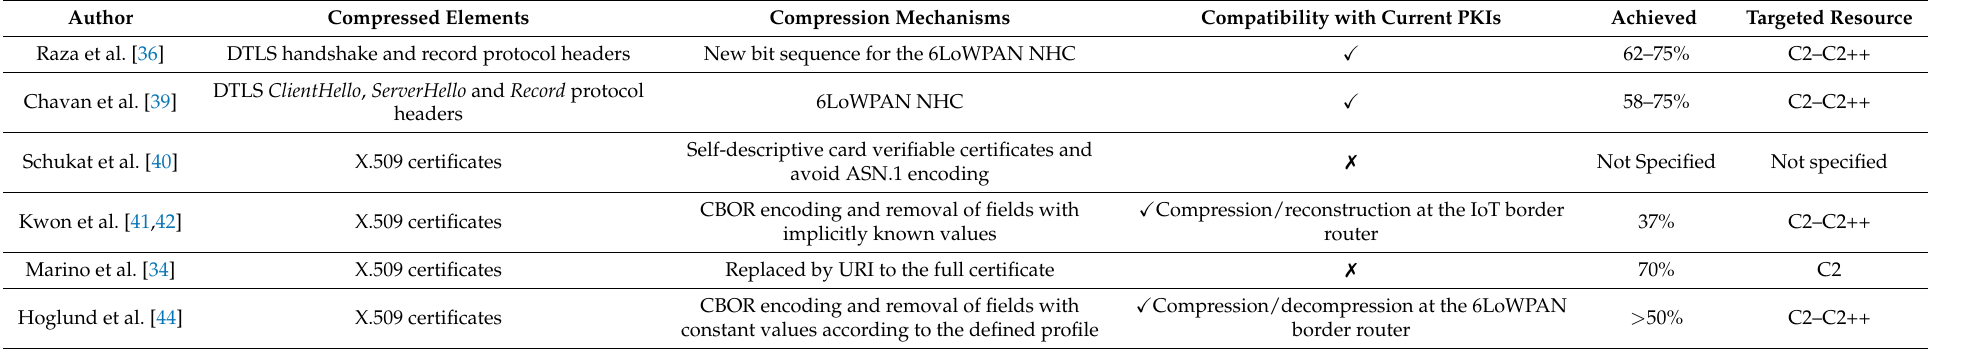
Table 3. Summary of compression-based